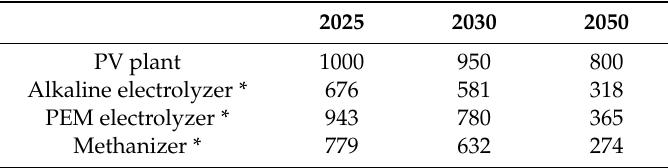
Table 4. Installation costs of the di ff erent systems of a PtG unit ( € / kW) (* own elaboration from [10]).